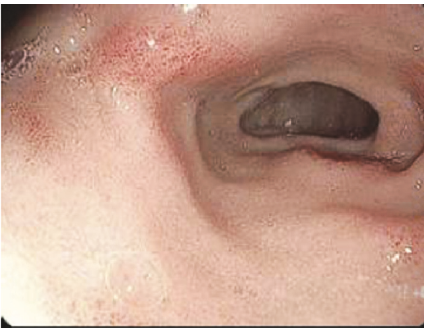
Figure 1: Endoscopic appearance of duodenal inflammation con- sistent with chronic GVHD on biopsy. This patient also had similar lesions in the gastric antrum to that depicted in this